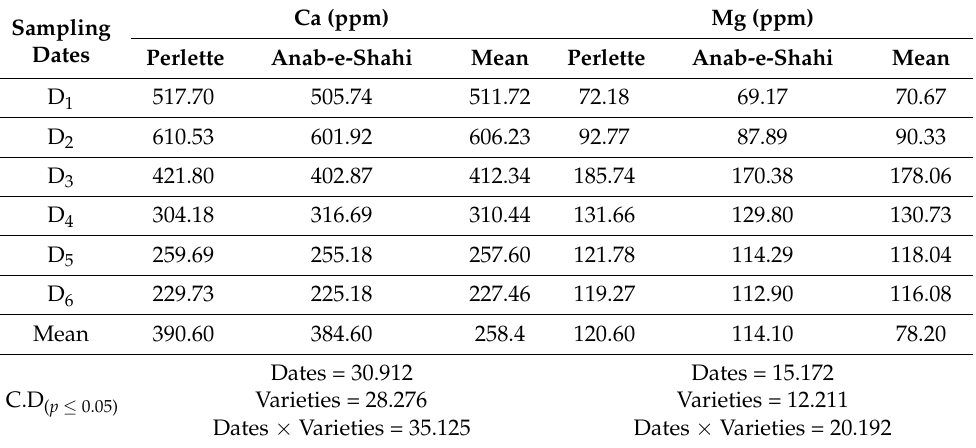
Figure 4. Change of Calcium (ppm) during the development of berries in grapes, cv. Perlette and Anab-e-Shahi. Table 2. Periodic variation of secondary nutrients in developing berries of grapes during the grow- ing